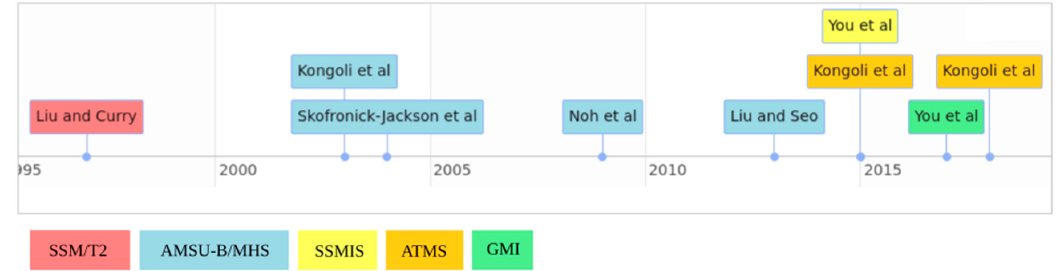
Figure 1. Timeline of several snowfall detection and retrieval algorithms. Box color indicates the instrument for which a given algorithm has been developed.